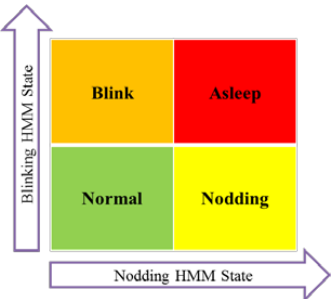
Figure 6. The criteria for determining driver’s state upon changes in nodding and blinking HMM (Hidden Markov Model)states.